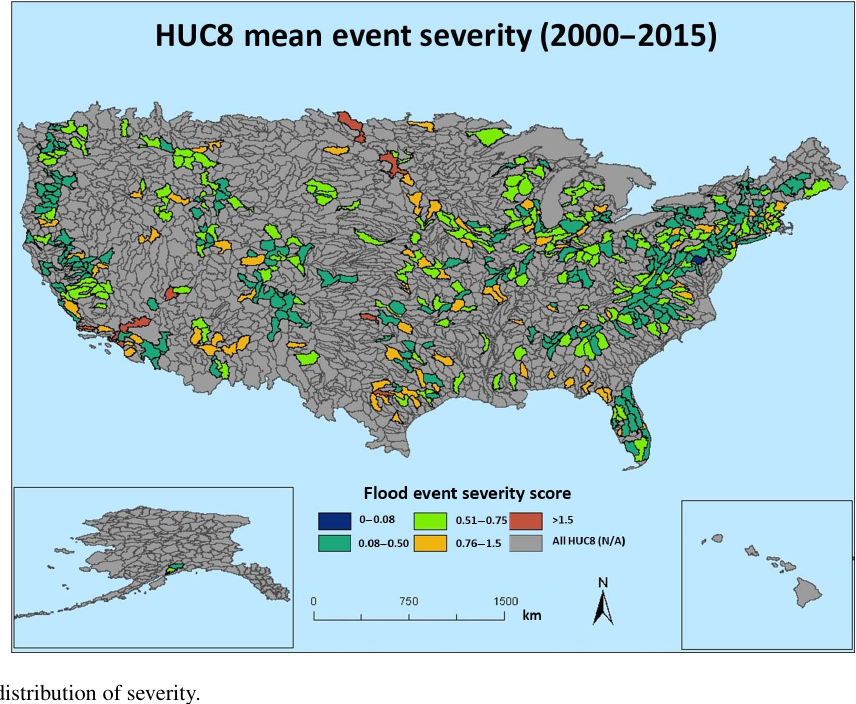
Figure 12. Regional distribution of severity.